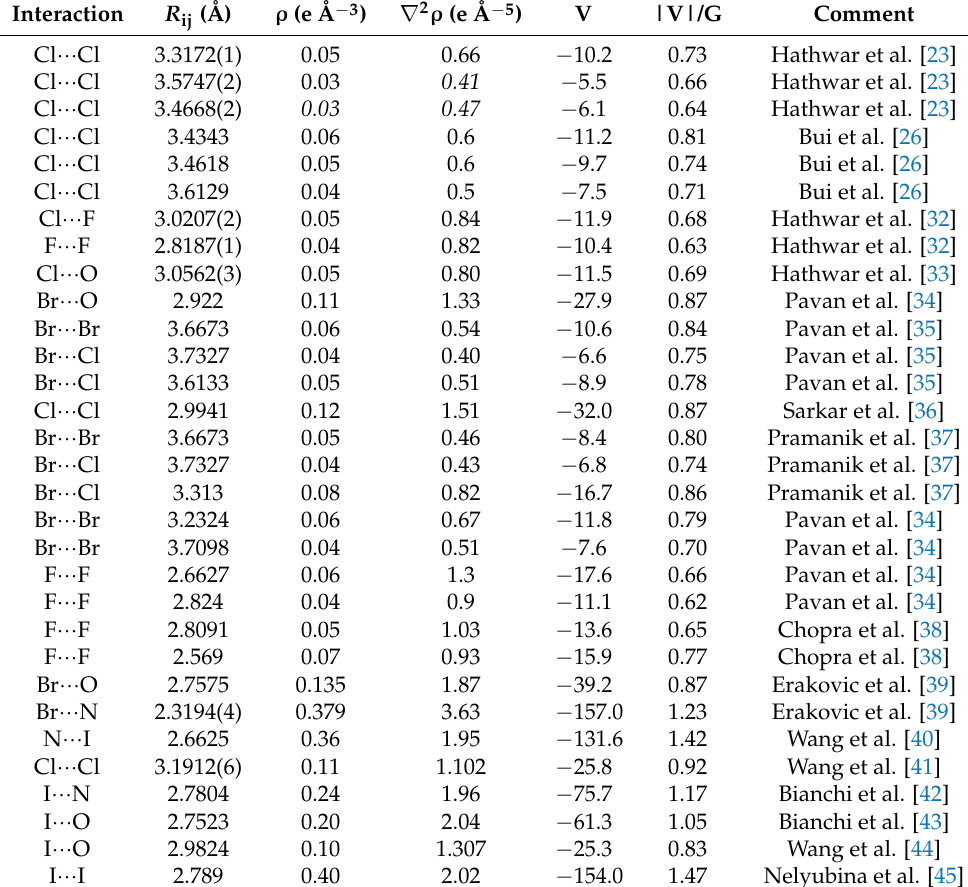
Table 2. Topological parameters from the experimental ED for noncovalent halogen interactions.